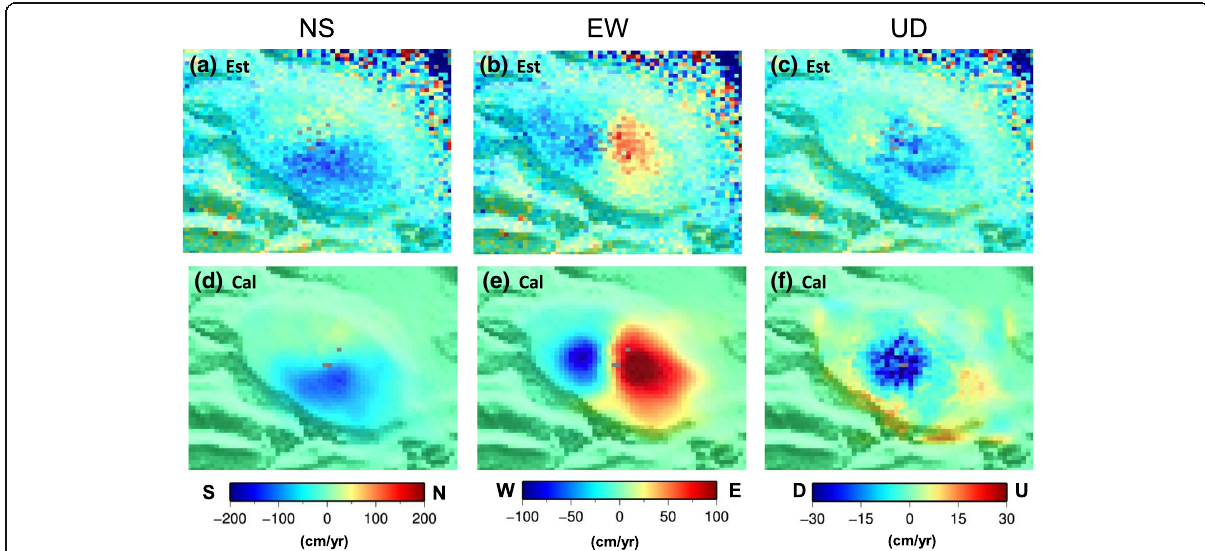
Fig. 10 3D displacements derived from both InSAR and MAI data, assuming constant velocity. a North-south displacement. b East-west displacement. c Up-down displacement. Also shown in d , e , and f are the predicted 3D displacements from the slip distribution model in Fig. 12. Positive signals indicate northward, eastward, and uplift movement, for a , d ; b , e ; and c , f respectively. Note the difference in the color bar